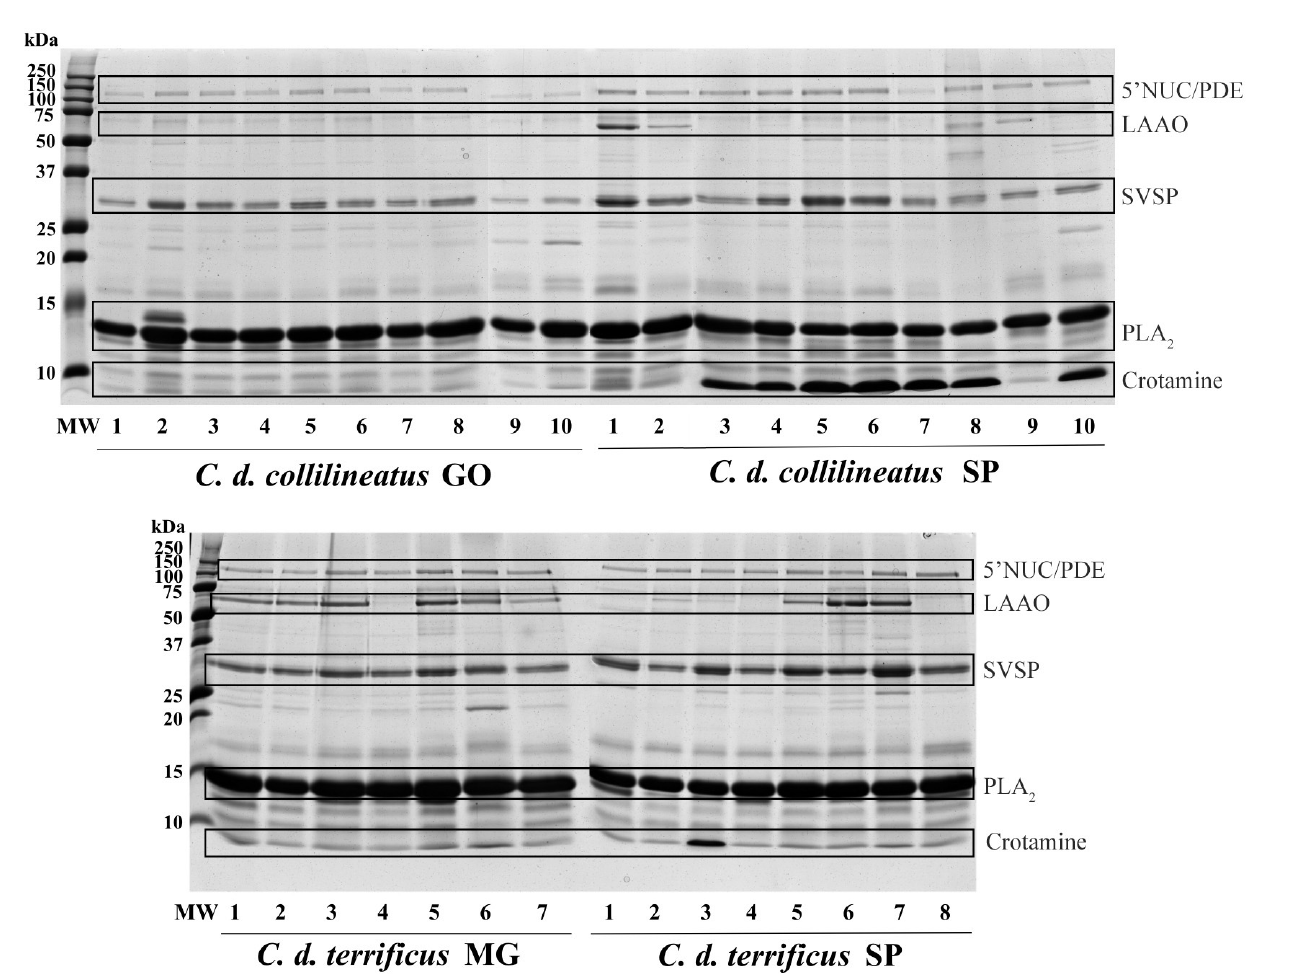
Figure 3. Electrophoretic profile of C. d. collilineatus and C. d. terrificus venom. Individual venom samples (20 µg) are subjected to SDS-PAGE 15%, under reducing conditions, and proteins were stained using Coomassie G (GE Healthcare). C. d. collilineatus GO: specimens from Goiás state; C. d. collilineatus SP: specimens from São Paulo state; C. d. terrificus MG: specimens from Minas Gerais state; C. d. terrificus SP: specimens from São Paulo state; MW: molecular weight marker (Dual Color Precision Plus Protein Standards – BioRad). The main protein bands were assigned to its major components. 5’NUC: 5’nucleotidases; PDE: phosphodiesterases; LAAO: L-amino acid oxidases; SVSP: snake venom serine proteases, PLA